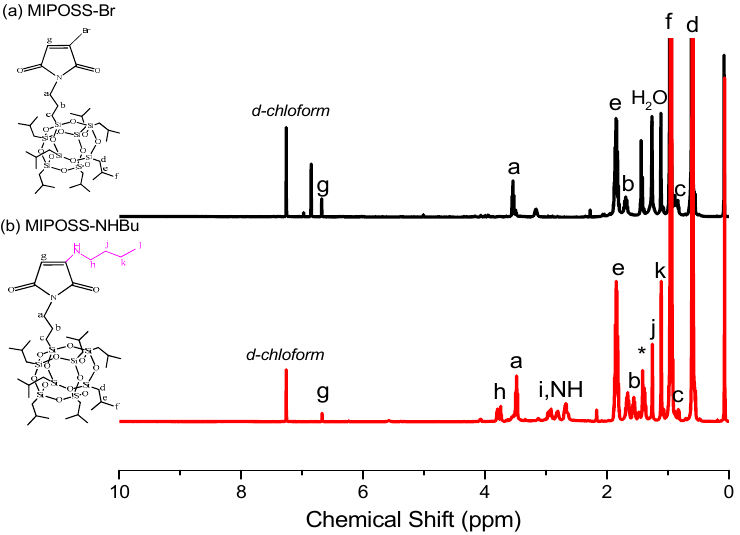
Figure 1. 1 H-NMR spectra of the monomers ( a ) MIPOSS-Br and ( b ) MIPOSS-NHBu.